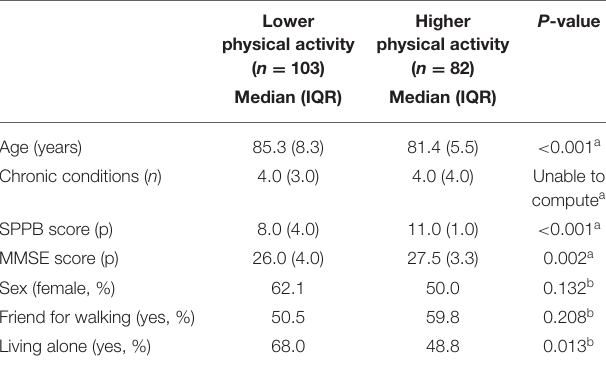
TABLE 1 | Descriptive characteristics of participants with lower and higher physical activity